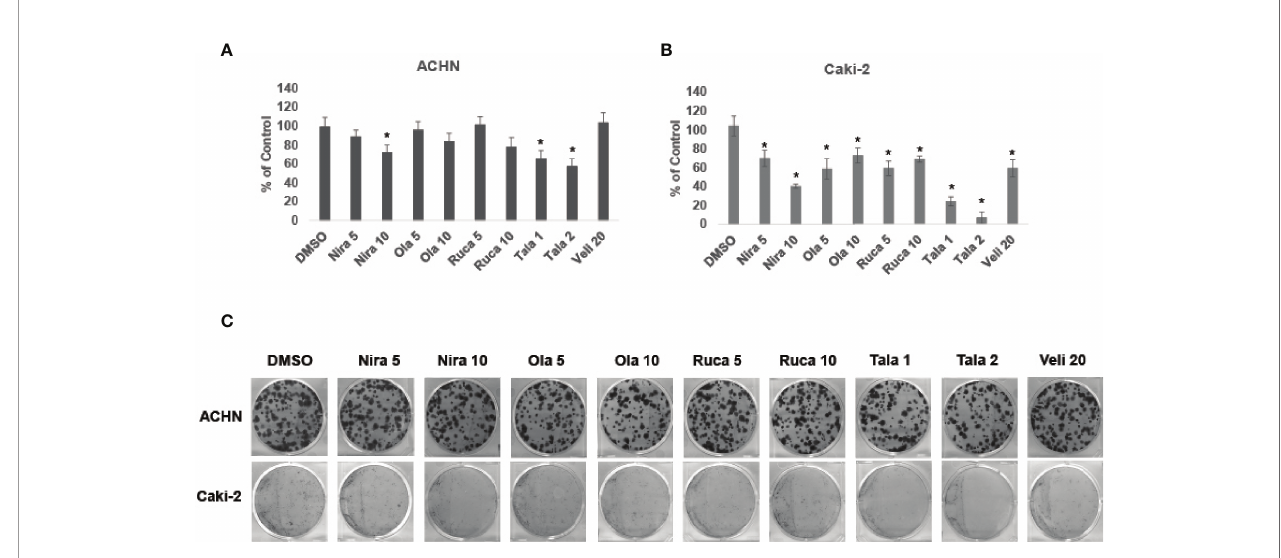
FIGURE 2 | PARPi inhibited the clonogenic ability of RCC cells. (A) ACHN and (B) Caki-2 cells were treated with 5 or 10 m M each of niraparib, olaparib, or rucaparib; 1 or 2 m M talazoparib; or 20 m M veliparib for 72 h. Cell were trypsinized and plated at low density (400 cells/well) in 6-well plates. Plates were left undisturbed for 10-14 days and the resulting colonies were stained with 0.5% crystal violet in buffered formalin. Colonies were counted using the ImageJ Colony Counter plug-in. Results are presented as means ± SD of 3 separate experiments with triplicates. P< 0.05 was considered signi fi cant (*). (C) Representative images of colonies formed by ACHN and Caki-2 cells in the different treatments are shown. Niraparib, Olaparib, and talazoparib were effective at reducing the clonogenic ability of ACHN and Caki-2 cells. Caki-2 cells were more sensitive to treatment with